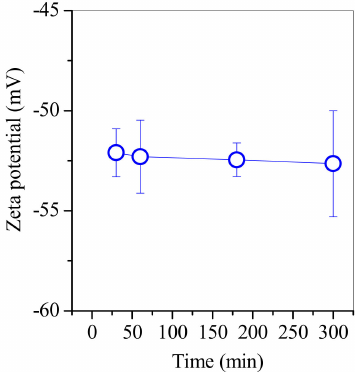
Figure 9. Zeta potential of SP2 in deionized